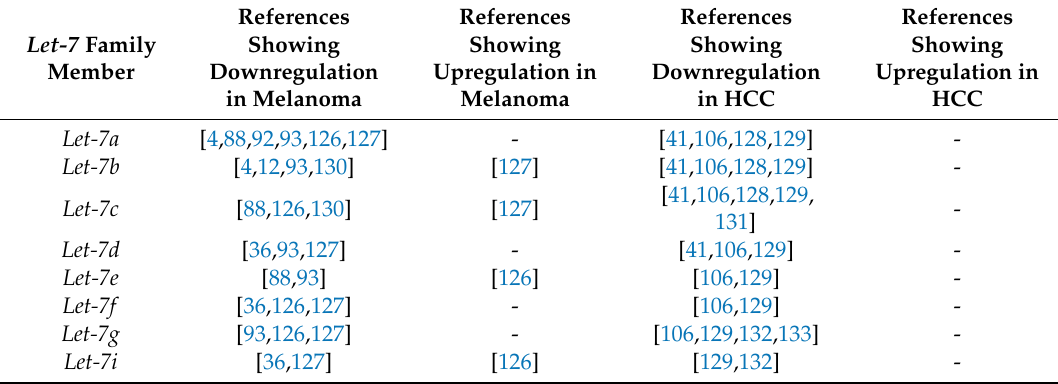
Figure 2. Let-7 members are strongly downregulated and function as potent tumor-suppressors in melanoma and hepatocellular carcinoma (HCC). References (numbers in brackets indicate according references of studies) showing differential expression (indicated by arrows) of single let-7 family members in melanoma and HCC. Table 1. References Depicting Differential Expression of single Let-7 Family Members in Melanoma and HCC.